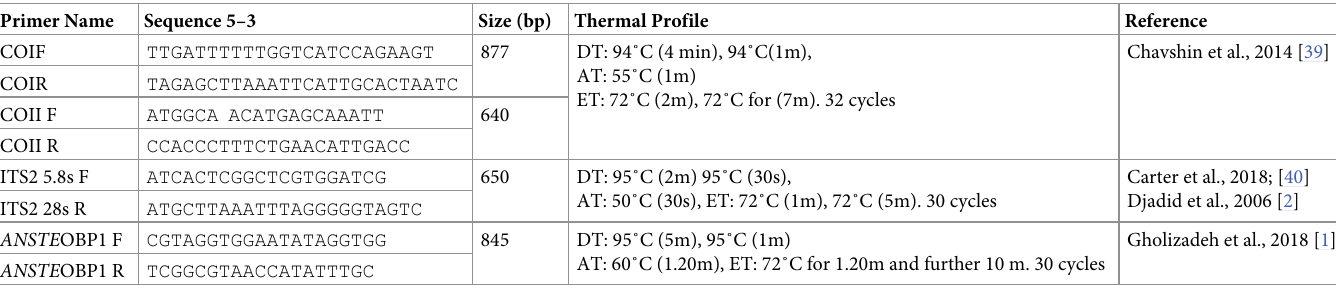
Table 1. Primers detail and their respective thermal profiles in PCR